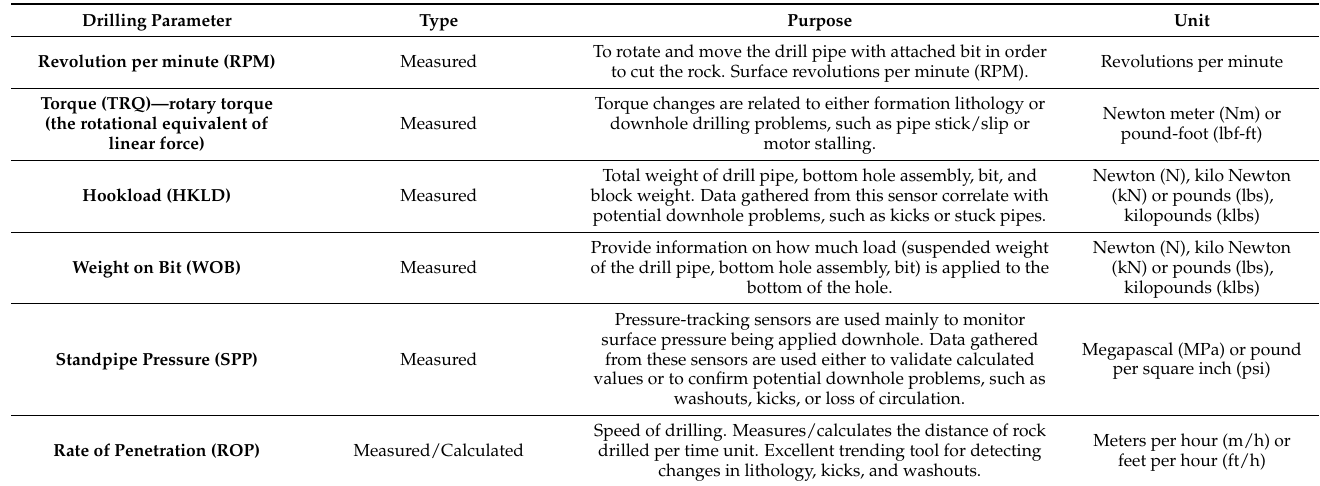
Table 1. A list of surface drilling parameters used in the